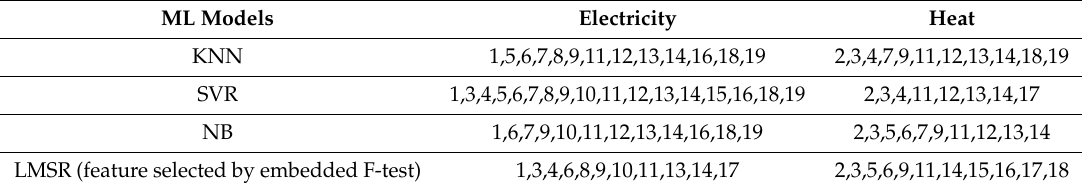
Table 3. Feature set selected by GA (or embedded F-test for Linear Model Stepwise Regression (LMSR)).